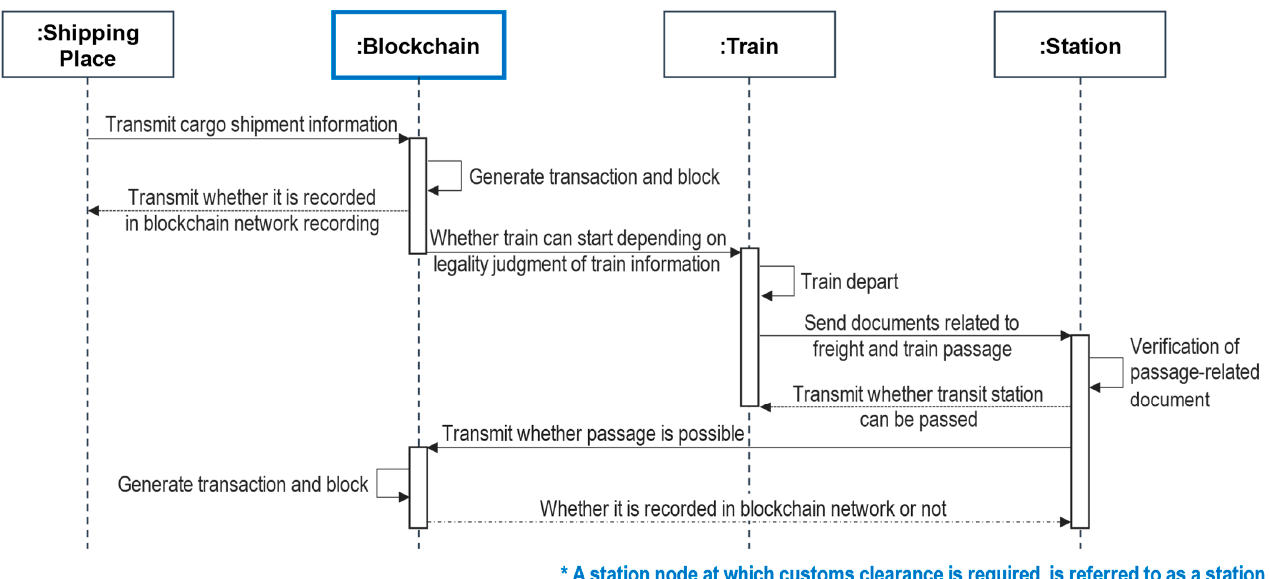
Figure 5. Basic sequence diagram of NSCC.